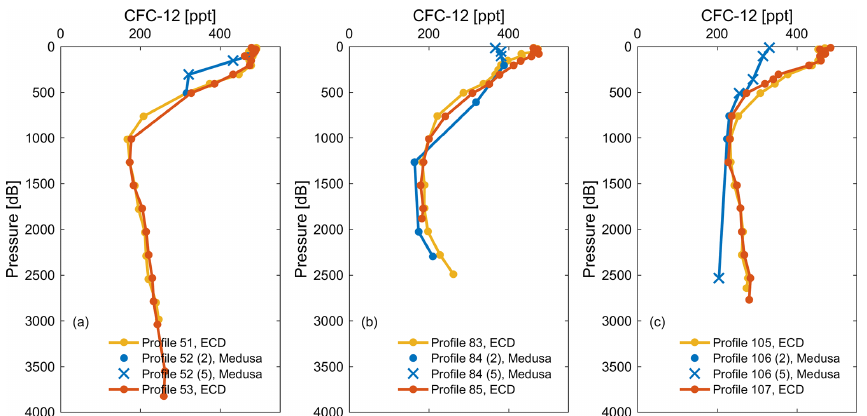
Figure 4. Comparison of CFC-12 observations from cruise MSM72 measured by the PT-GC-ECD (ECD) and the Medusa–Aqua system (Medusa) in three areas: (a) southern Ionian Sea, (b) Tyrrhenian Sea, and (c) western Mediterranean Sea. Samples flagged as good (flag 2) are shown as dots, whereas for samples that are deemed inconsistent with PT-GC-ECD samples are flagged as likely bad (here we used flag 5; see text). In the following plots, we show all data with a quality flag of 2 (dots) or 5 (crosses). Table 2. Comparison of instrument performance measuring CFC-12.